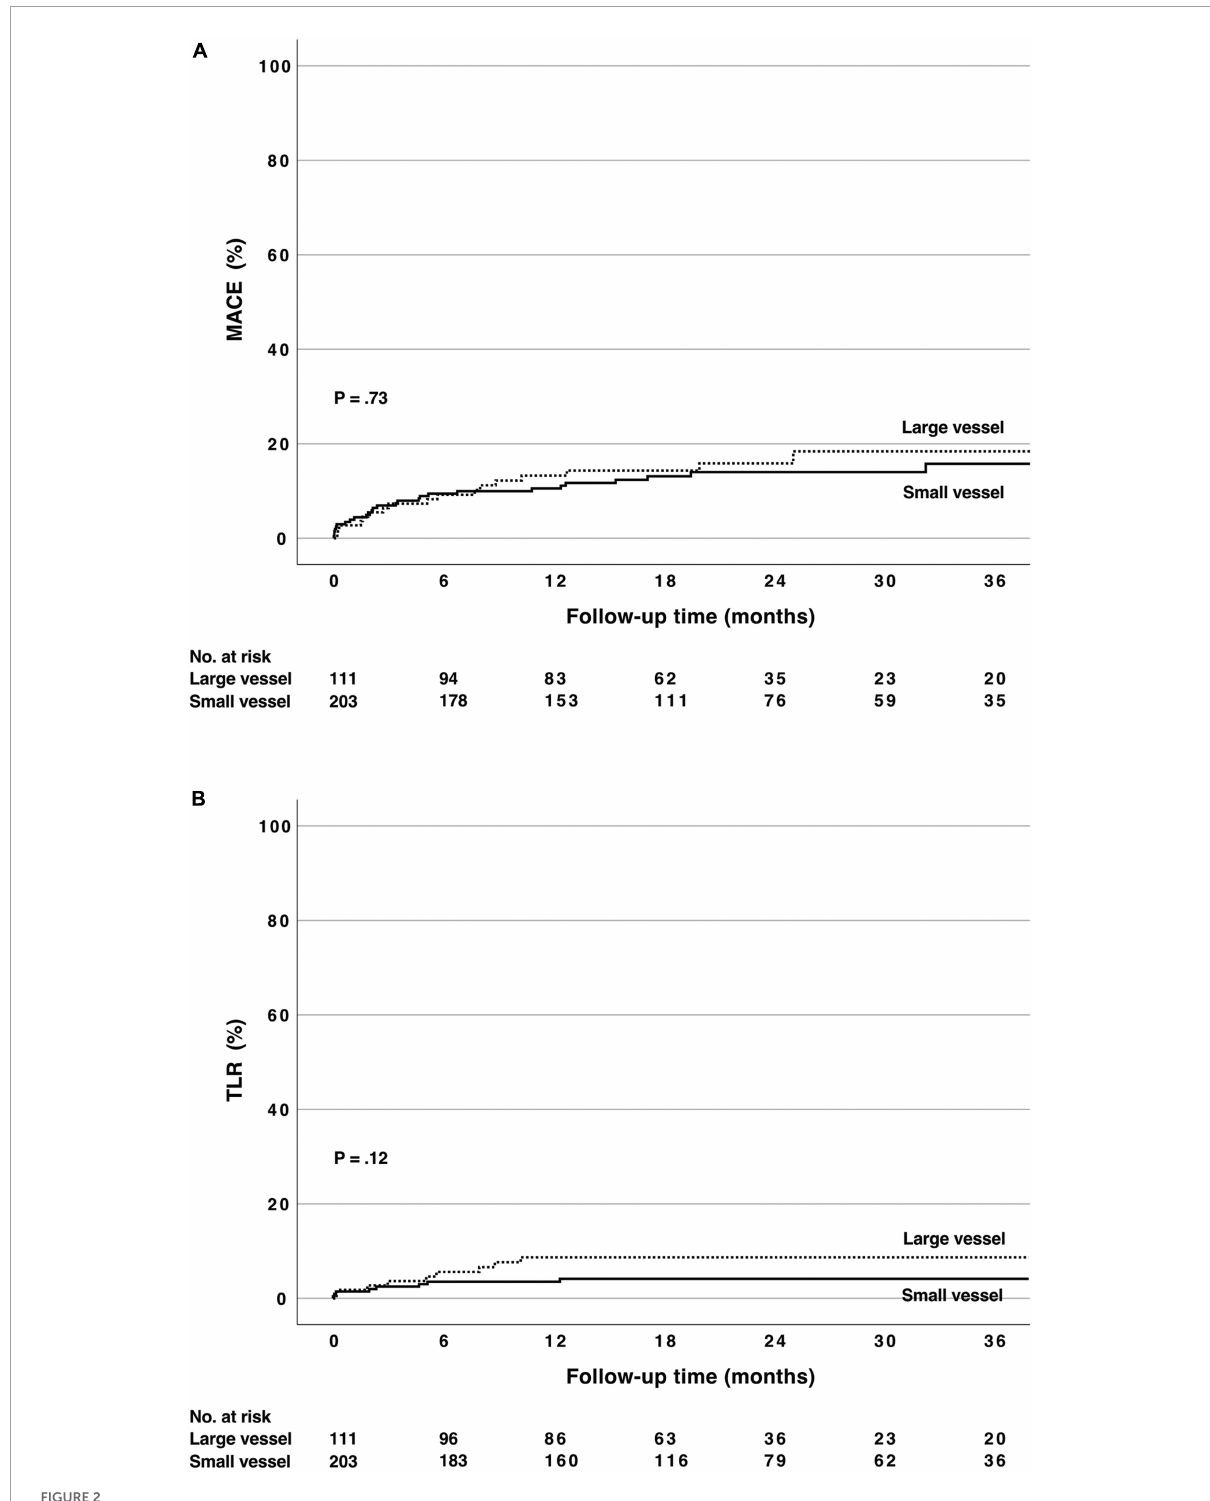
FIGURE2 (A) Cumulative major adverse cardiovascular events rate [consisting of cardiac death, non-fatal myocardial infarction and target lesion revascularization (TLR)] after PCI using paclitaxel drug-coated balloon with citrate ester excipient as an excipient in small ( ≤ 2.75 mm) and large vessels ( > 2.75 mm). (B) Cumulative TLR rate in the same subgroups. There was no statistically significant difference between the groups (log rank p = ns). MACE, major adverse cardiovascular events; TLR, target lesion revascularization; DCB, drug-coated balloon; CEE, citrate ester